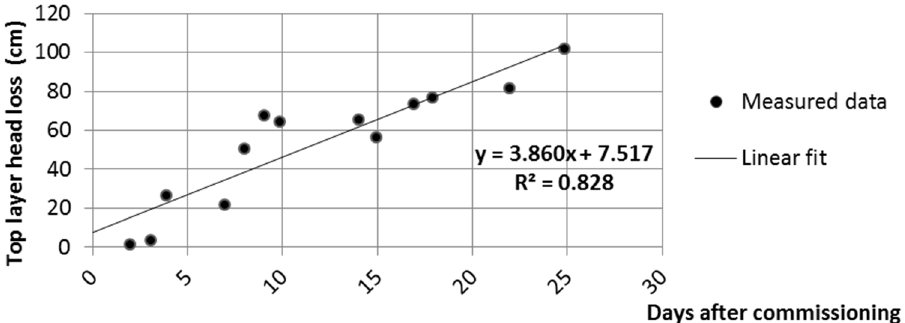
Figure 4. The relationship between the top layer and the days after commissioning.